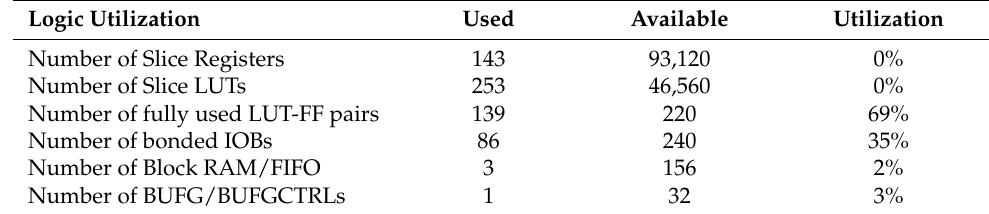
Table 5. Device-utilization summary (estimated values) for proposed BISR top on